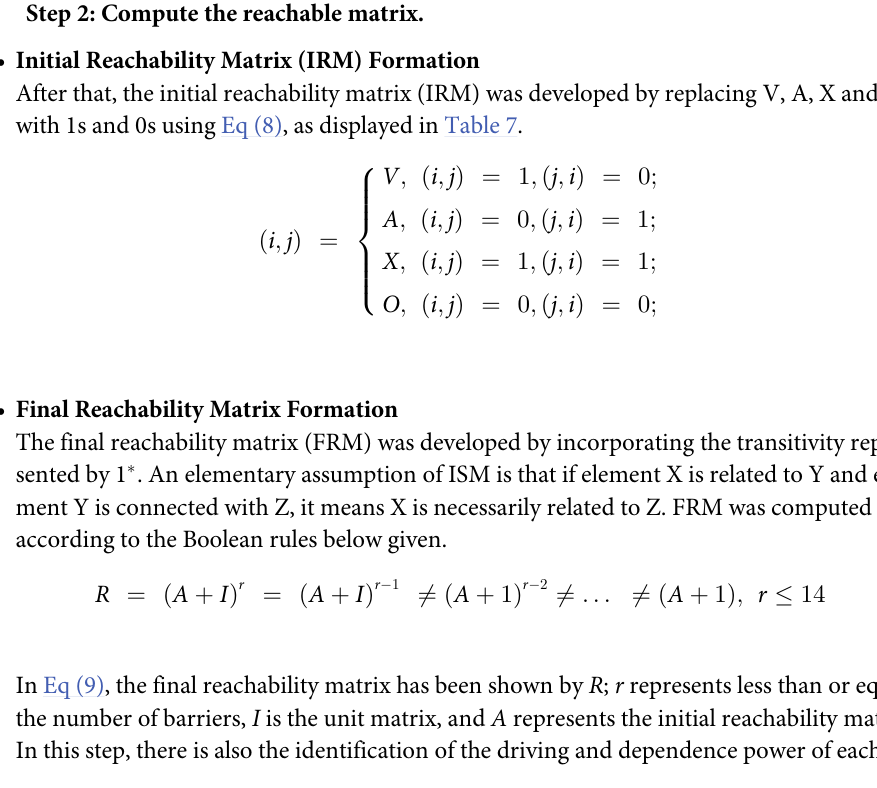
In Eq (9), the final reachability matrix has been shown by R ; r represents less than or equal to the number of barriers, I is the unit matrix, and A represents the initial reachability matrix. In this step, there is also the identification of the driving and dependence power of each